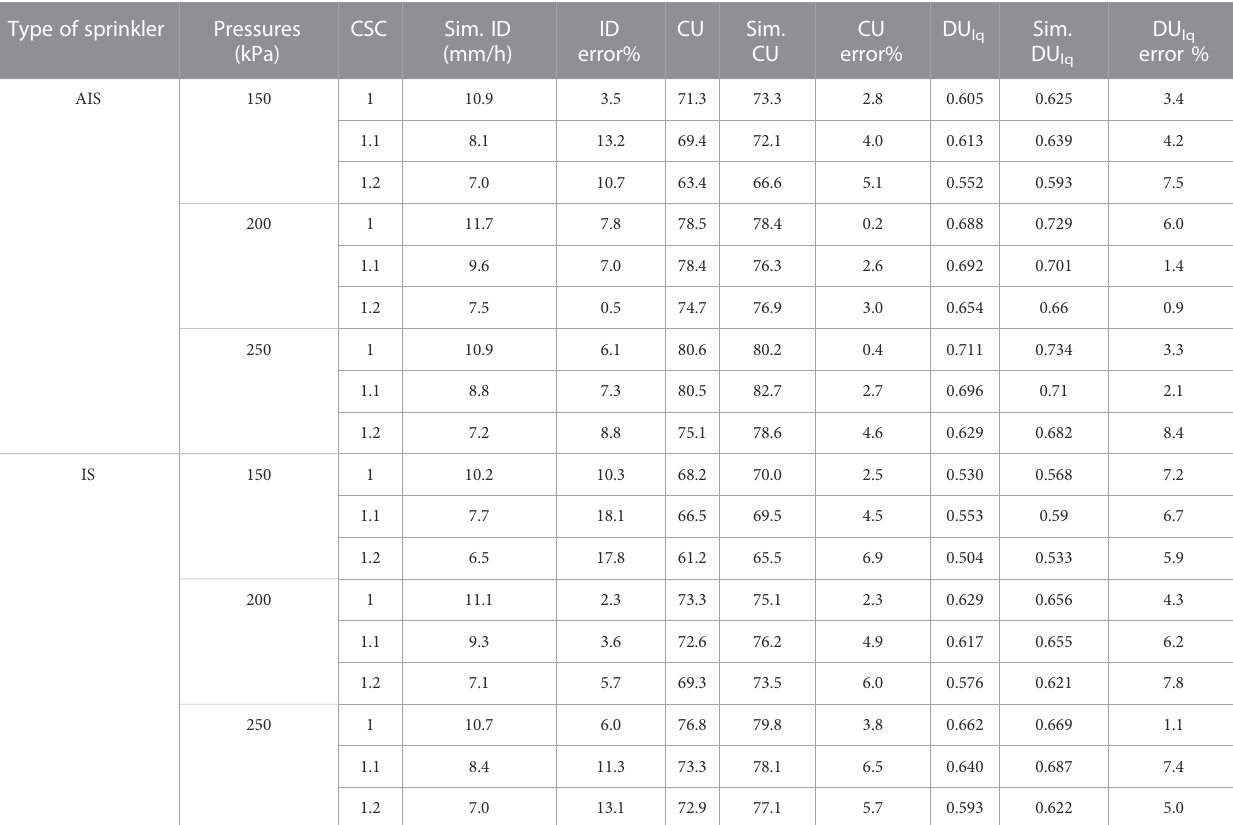
TABLE 4 The Comparison of the simulated sprinkler irrigation with the outdoor experimental results. Type of